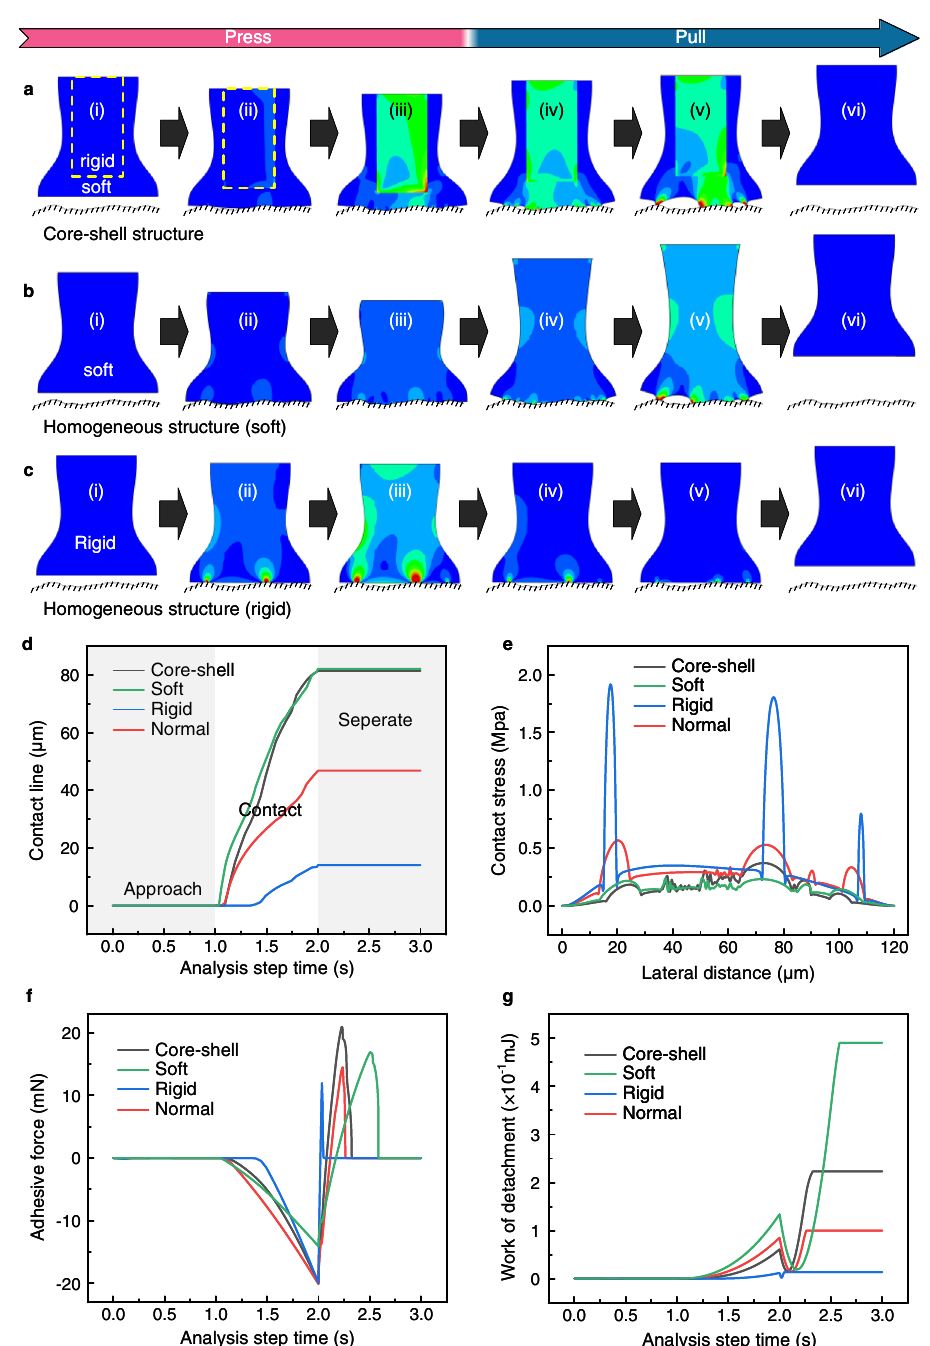
Fig. 3 | Adhesion enhancement mechanism of the grown core – shell structures on rough surfaces. a – c Dynamic behavior of the core – shell structure ( a ), soft structure( b ),andrigidstructure( c )onroughsurfaceswhen(i)approaching,(iiand iii) contacting, and (iv – vi) separating from the rough surface; cloud atlas repre- senting the internal stress. d Evolution of the contact line for different adhesive structure as a function of the process time. e Stress at the interface between the adhesive structure and the rough surface. f Adhesive force as a function of the